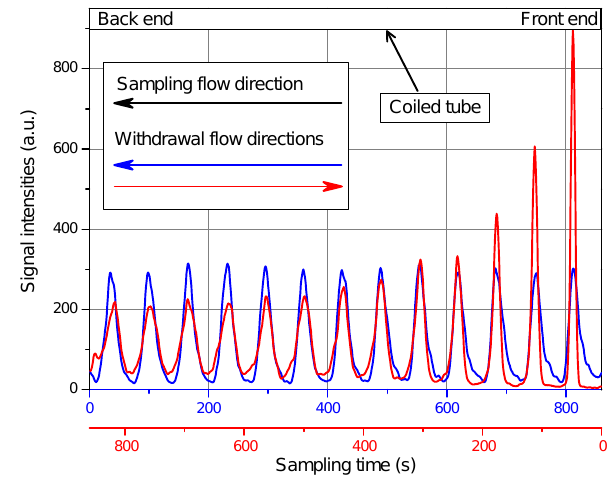
Fig. 6. The intensity of propene signals under different withdrawal flow directions. The blue line indicates that the inlet of PTR-TOF- MS is connected to the back end of the WASP tube, the red line indicates that the inlet of PTR-TOF-MS is connected to the front end of the WASP tube. The color of the x axis labels correspond to the withdrawal flow directions. The coiled tube setup is shown on the top of the